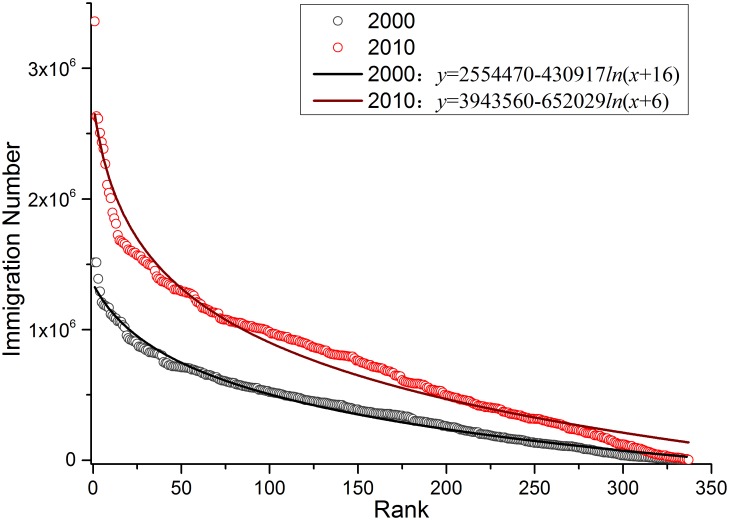
Scatter plot of urban immigration numbers in 2000 and 2010.2000, 2010, 2000: y = 2554470-430917ln(x+16), 2010: y = 3943560-652029ln(x+6).